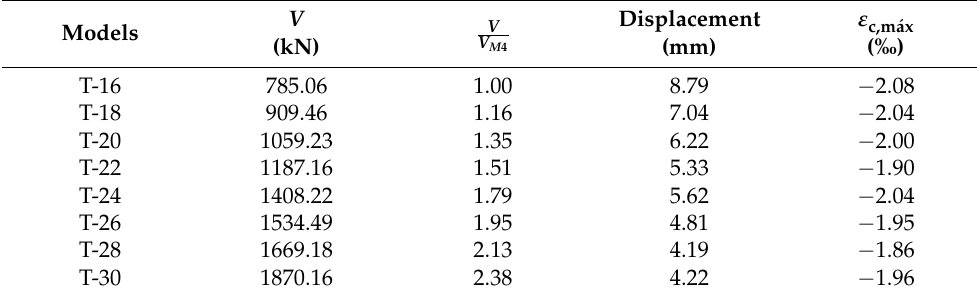
Table 4. Results obtained with Series T.